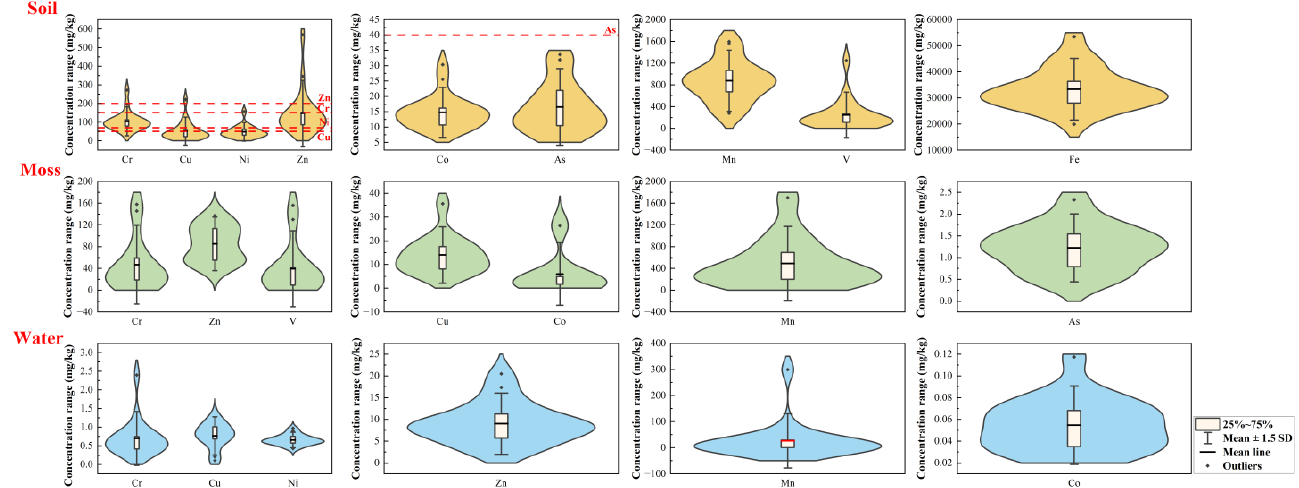
Figure 2. Violin diagram of selected metal(loid) contents in SNJ soil, moss, and water. The mean values of Cr, Cu, Ni, Co, Zn, Mn, and V contents in water were 0.70,